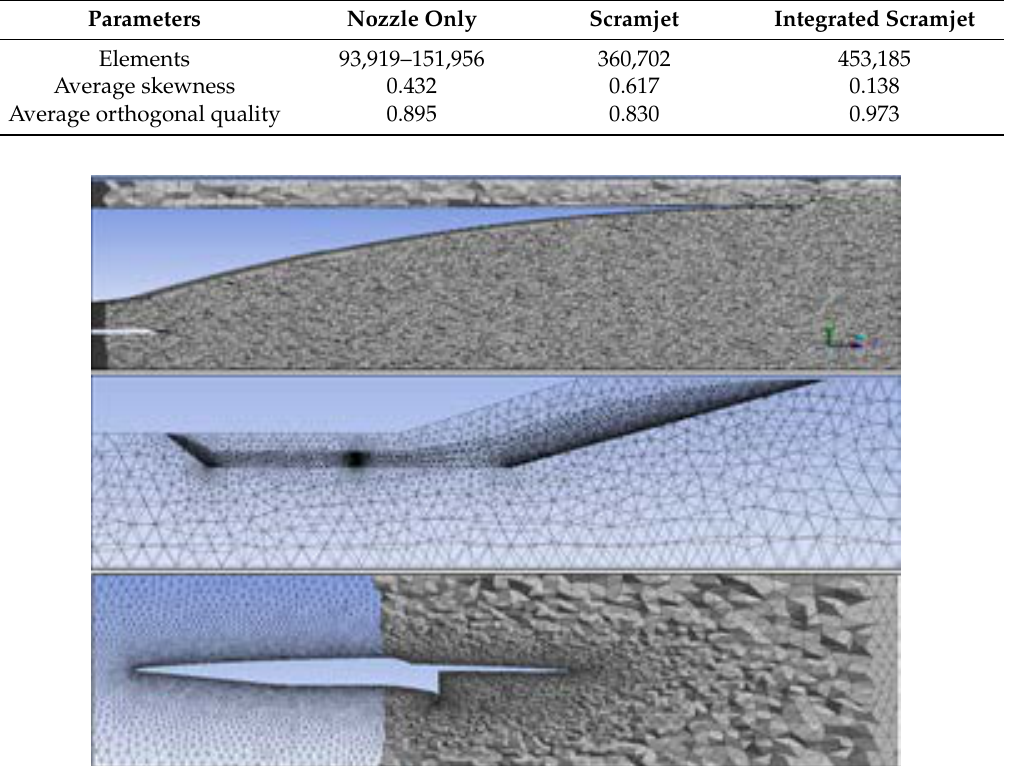
Table 2. 2D mesh statistics.